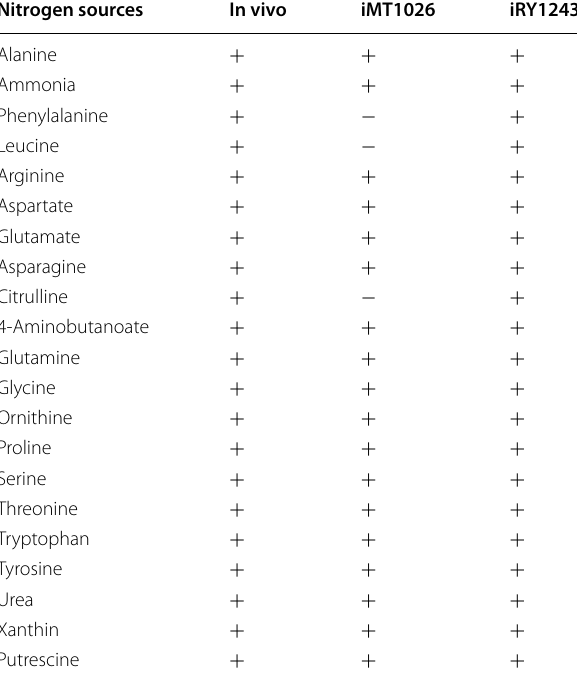
for growth and for non- + −